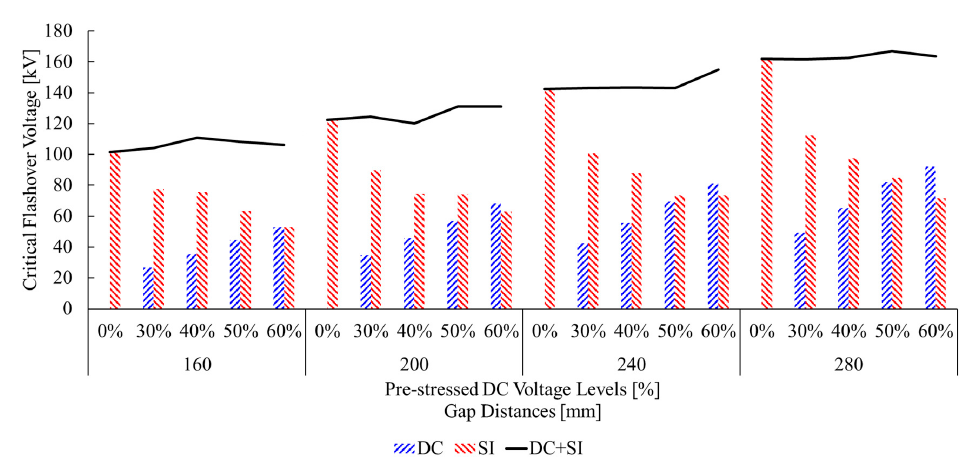
Figure 9. The experiment results of positive DC superimposed positive switching impulse for R10.